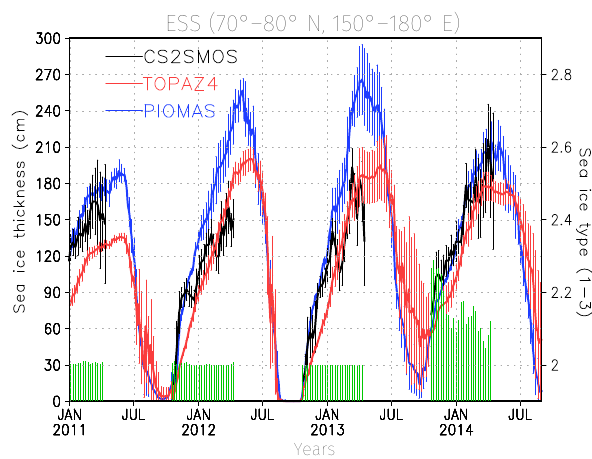
Figure 3. Time series of daily mean SIT (centimetres) averaged over the ESS (rectangular region denoted by black line in Fig. 1a) derived from CS2SMOS (black), TOPAZ4 reanalysis (red) and PI- OMAS (blue) from January 2011 to August 2014. For CS2SMOS data, 7-day mean values are shown. The standard deviations of area- averaged data are shown by vertical lines. The ice types (2: first-year ice, 3: multi-year ice) used for the choice of satellite SIT retrievals in CS2SMOS are shown by green bar. The scale for the ice type is located on the right vertical axis.